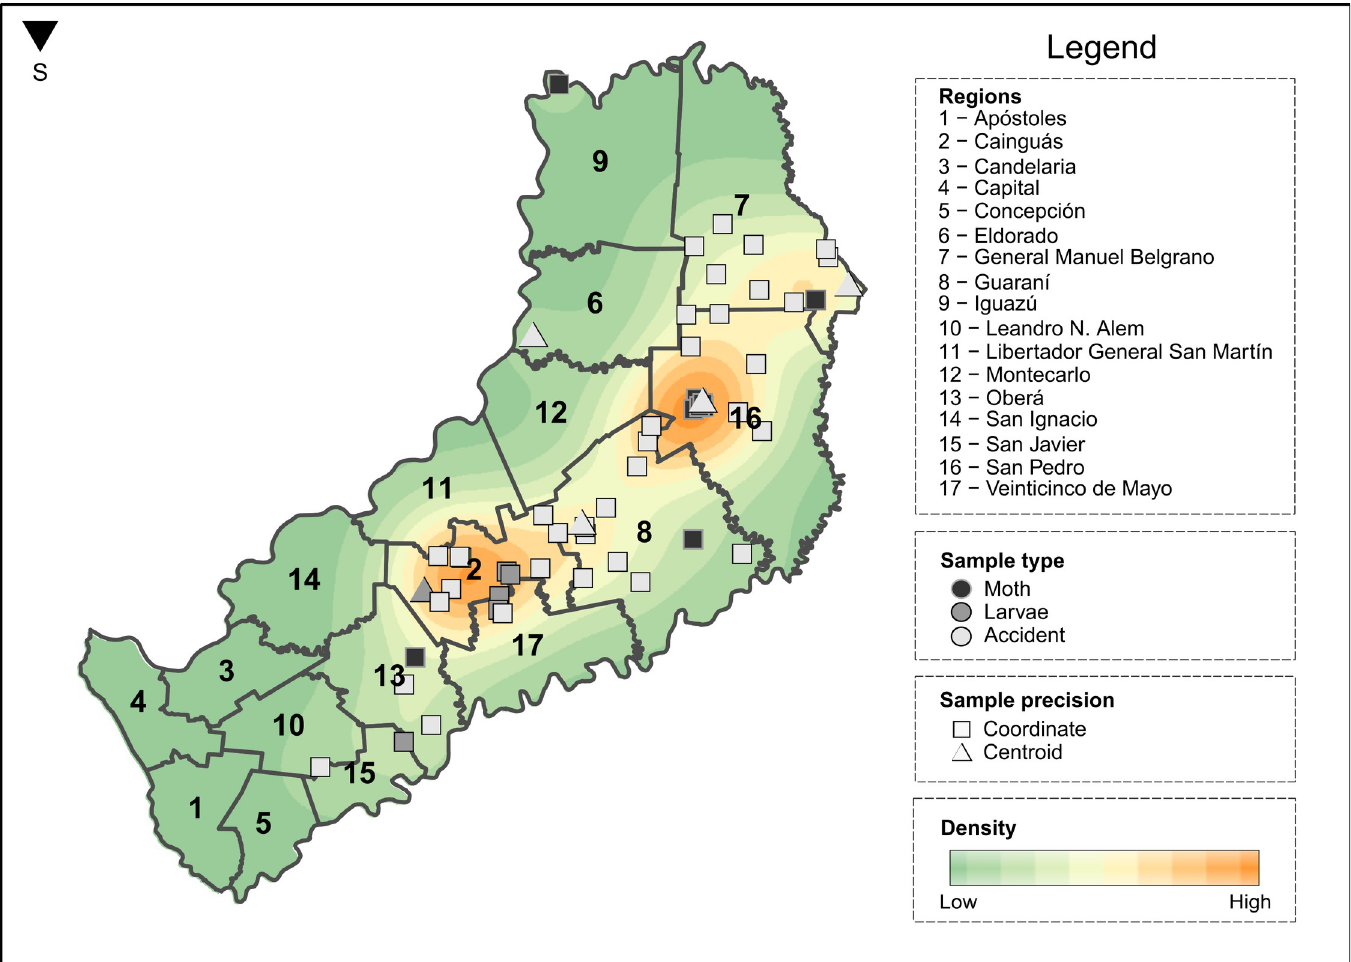
Fig 6. Lonomism risk map for Misiones, Argentina (January 26 th , 2014—May 8 th , 2020) using kernel density estimation. The map was constructed in R version 4.0.2, using layers downloaded from the National Institute of Geography (https://www.ign.gob.ar/NuestrasActividades/InformacionGeoespacial/CapasSIG) as basemap.